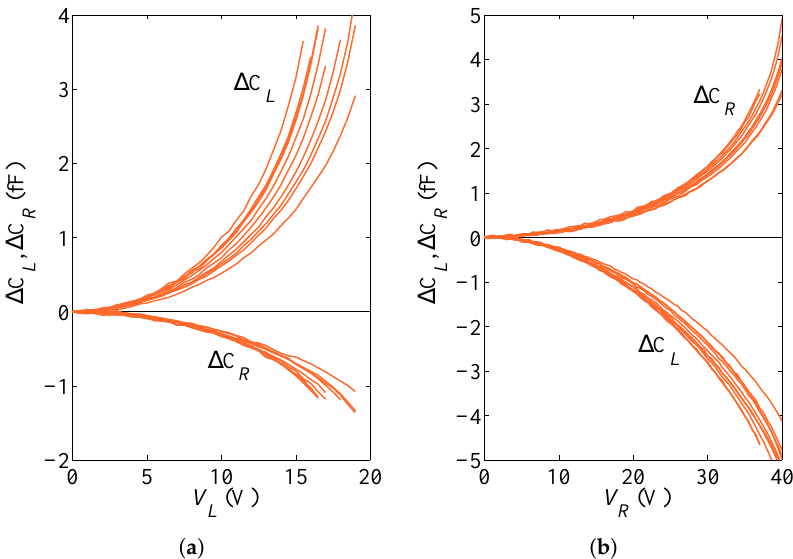
Figure 2. Experimentally measured capacitance change values ∆ C L and ∆ C R under ( a ) lateral actuation through V L , and ( b ) rotational actuation through V R